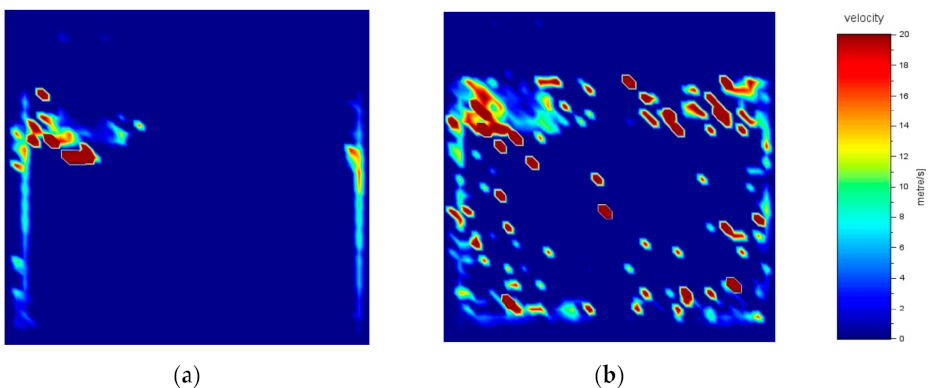
Figure 11. The distribution of particle speeds for the ( a ) single and ( b ) double rotor crushing environments, at 1080 rpm impeller